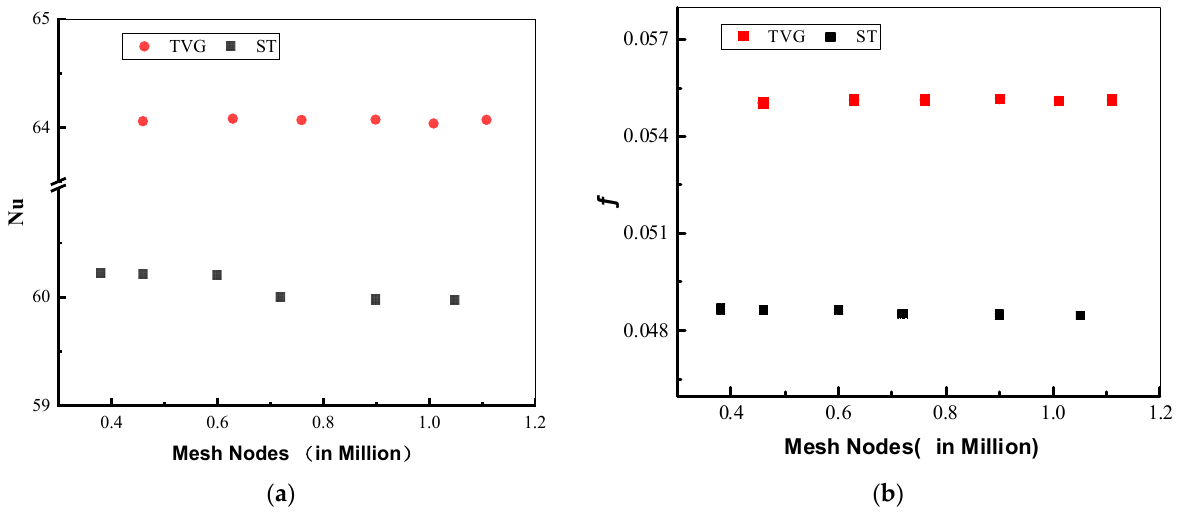
Figure 4. Grid independency verification; ( a ) grid independency verification of Nu ; ( b ) grid inde- pendency verification of f .